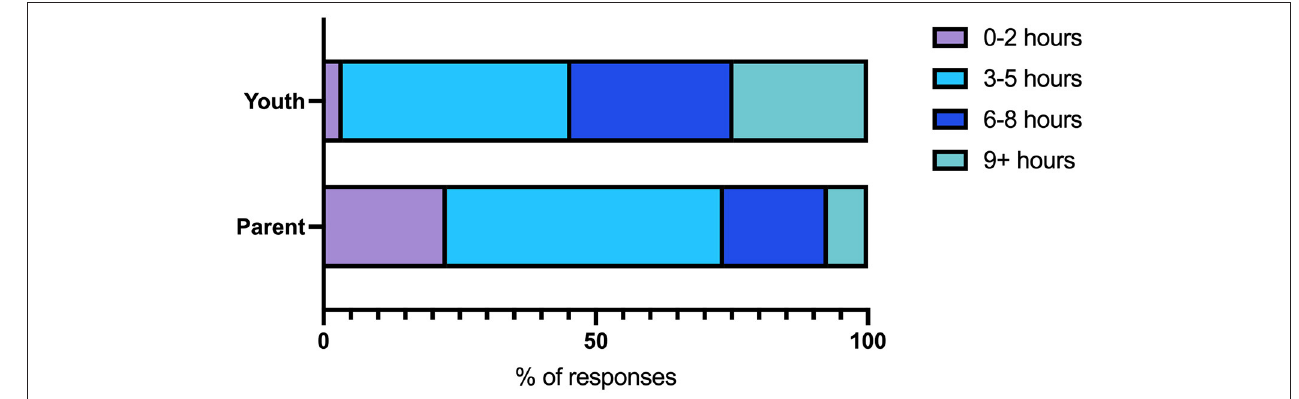
FIGURE 6 | Number of hours of screen time within a 24-h period as reported by children and youth or